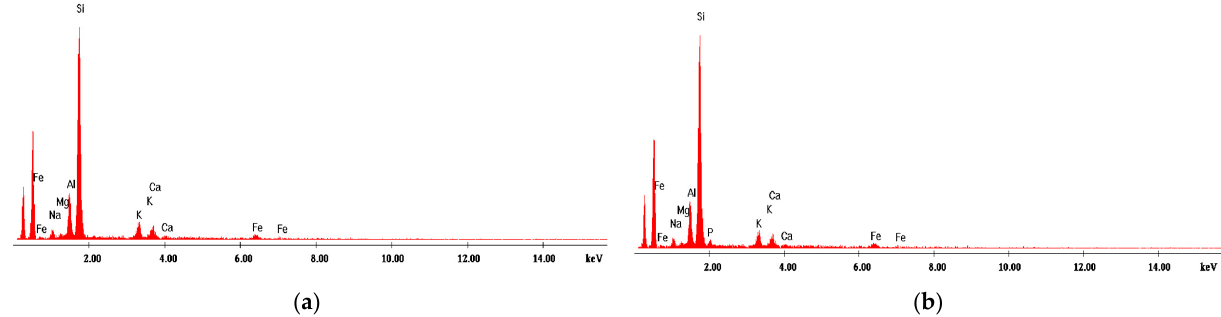
Figure 5. EDX analysis of zeolite ( a ) before and ( b ) after phosphorus adsorption.